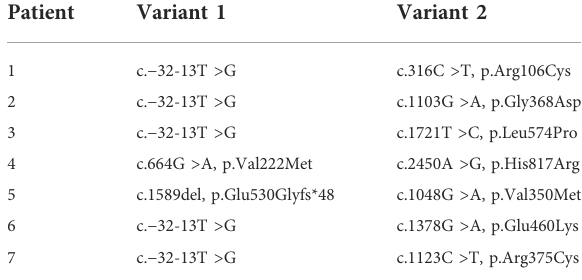
TABLE 2 Genotypes of patients whose variants were selected for functional analysis. All patients had a con fi rmed pathogenic variant (Variant 1) except Patient